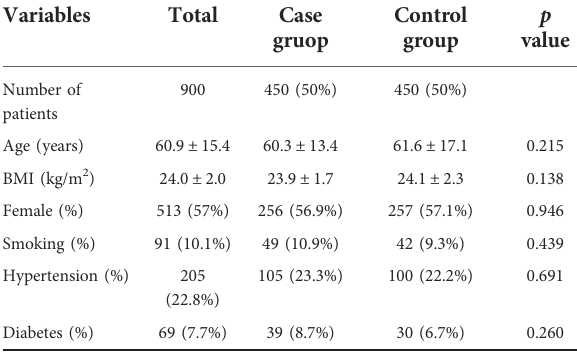
TABLE 2 Baseline characteristics of case group and control group by 1:1 matching on propensity